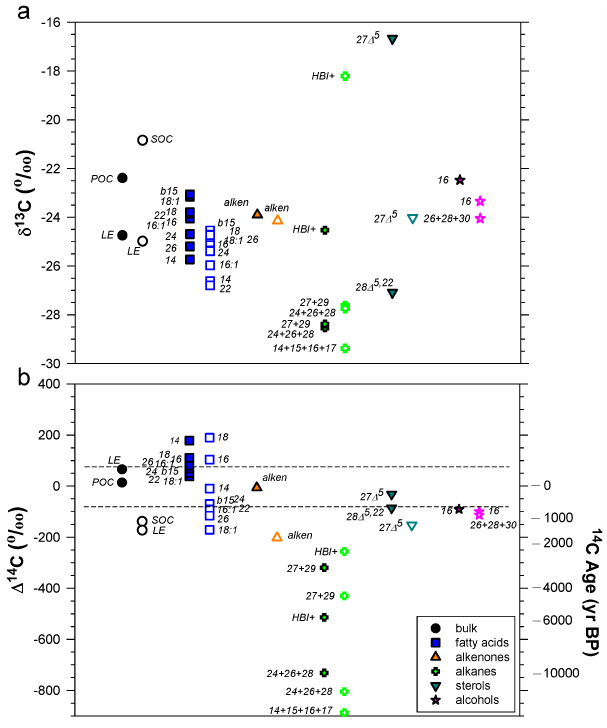
Figure 9. The (a) δ 13 C and (b) (cid:49) 14 C values of bulk POC and SOC and individual biomarkers for trap and sediments from the Ara- bian Sea (see also Table 2). Filled symbols are trap biomarkers; open symbols are sediment biomarkers. All values have been cor- rected for procedural blanks and any derivative carbon, as needed. Dashed lines are pre-bomb (lower) and post-bomb (upper) mixed- layer (cid:49) 14 C DIC